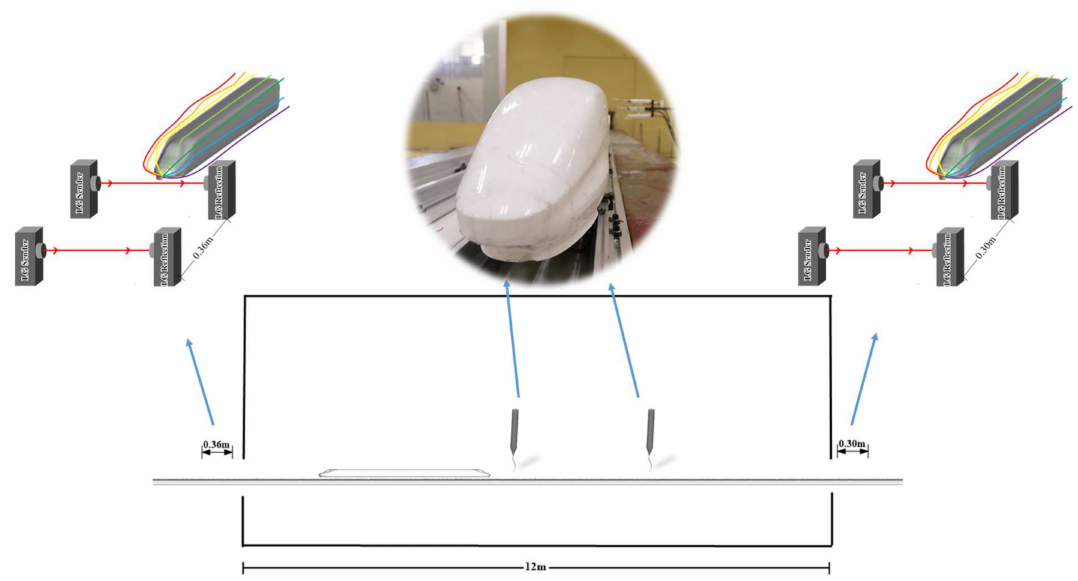
Figure 3. Train speed and train induced wind velocity measurement